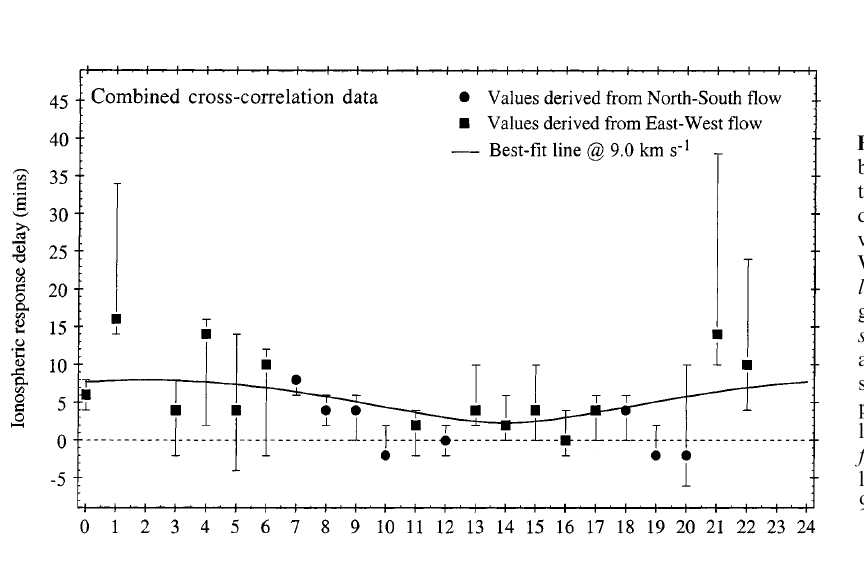
Fig. 5. b As for a , except for the v nent of ionospheric flow. The squares indicate the region of negative cross-correlation values (northward flow for southward IMF), while the circles indicate the region of positive values (equatorward flow for southward IMF)